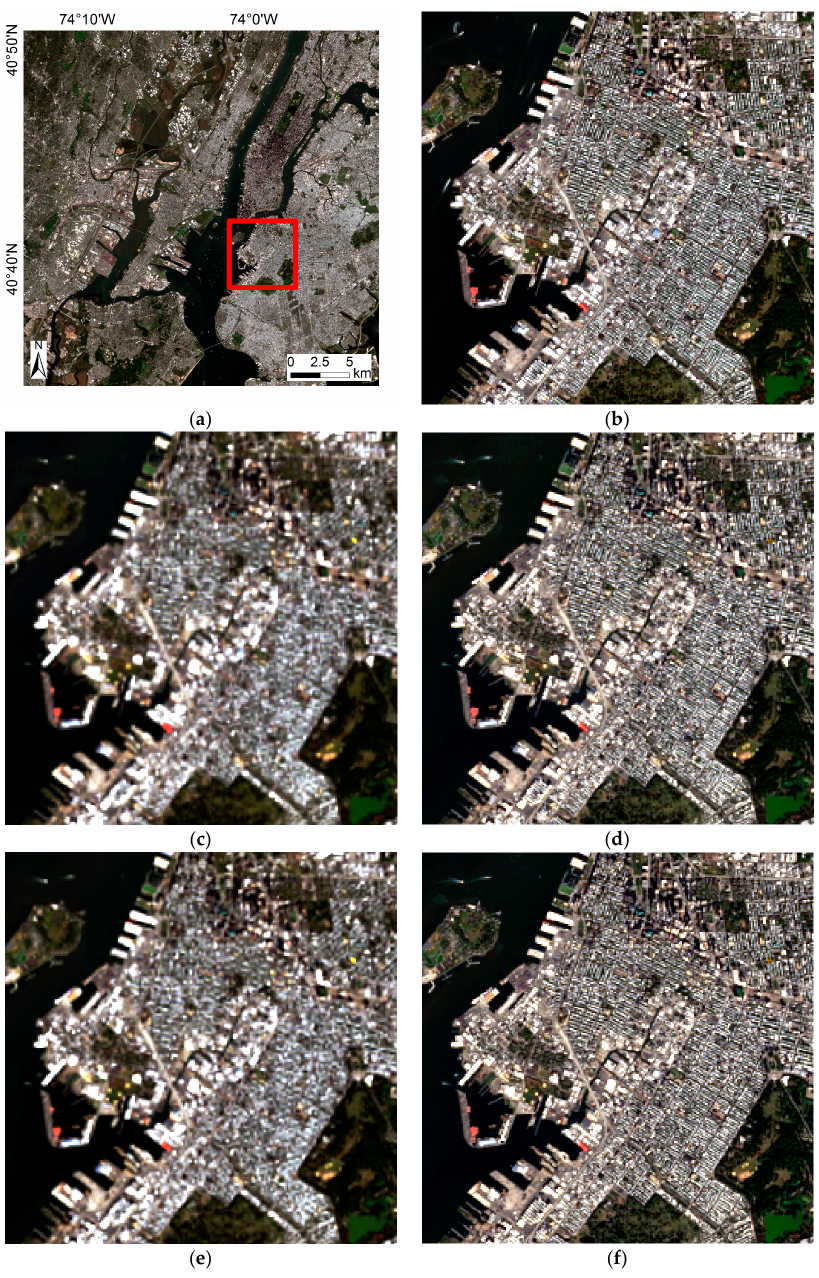
Figure 4. New York city true color images showing: ( a ) Sentinel-2A 20-m image (1500 × 1500 20-m pixels) and sub-set (red box); ( b ) Sentinel-2A 256 × 256 20-m pixel sub-set; ( c ) Landsat-8 bilinear resampled to 20 m; ( d ) Landsat-8 bilinear-based LPAD 20-m data; ( e ) Landsat-8 cubic convolution resampled to 20 m; ( f ) Landsat-8 cubic convolution-based LPAD 20-m data.